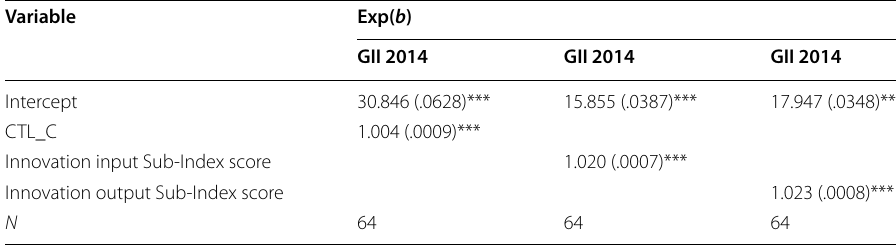
Table 7 Regression Global Innovation Index